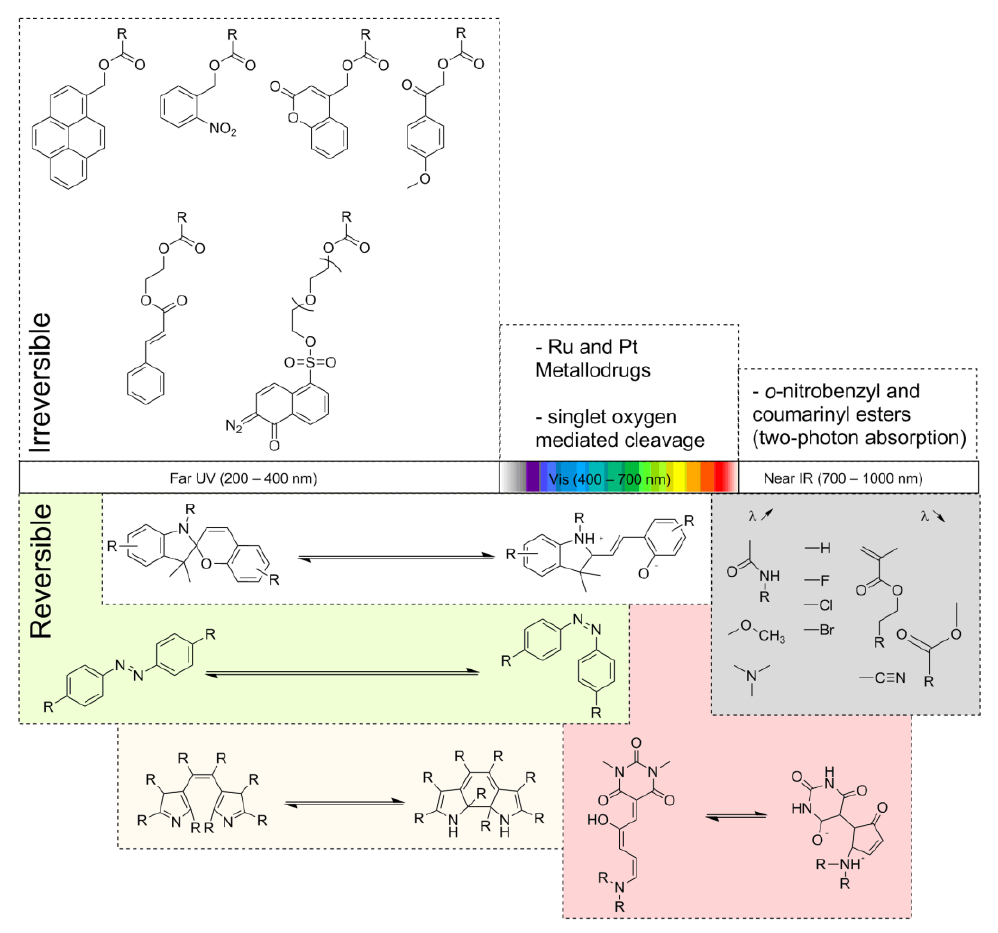
Figure 1. Schematic representation of relevant chromophores that have been incorporated into block copolymers; we distinguish between reversible/irreversible photo-response as well as different excitation regimes: Far UV (200–400 nm), Vis (400–700 nm) and Near IR (700–1000 nm); the grey part depicts different functional groups that are capable of influencing the wavelength at which chromophores respond.